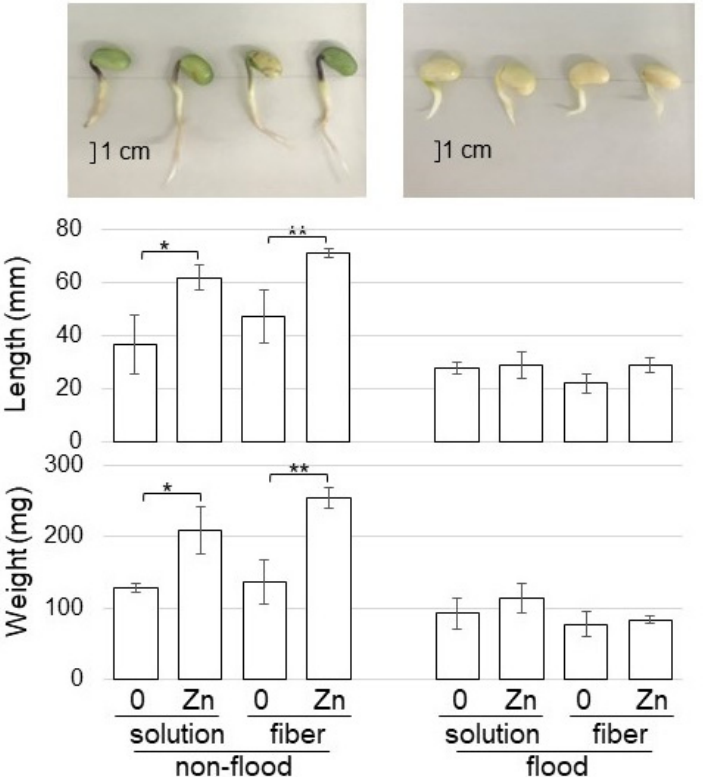
Figure 6. Morphological effect of fiber crosslinked with ZnO on soybean growth under flooding stress. Soybean seeds were sowed on the BL-fiber or solution with 1 ppm ZnO NPs with 200 nm. For the non-flooded group, samples were collected at four days after sowing. For the flooded group, soybean seedlings were exposed to two-day-flooding after two-day-germination, and samples were collected. The fresh weight and length of hypocotyl and root were measured as morphological parameters. The bar in the photograph indicates one cm. The data are given as the mean ± S.D. from three independent biological replicates. Asterisks indicate significant changes between the two treatments according to Student’s t -test (** p < 0.01; * p < 0.05).